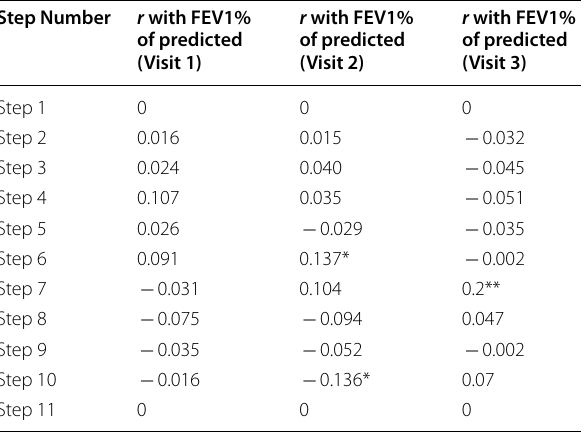
*Significant at the 0.05 level; **Significant at the 0.01